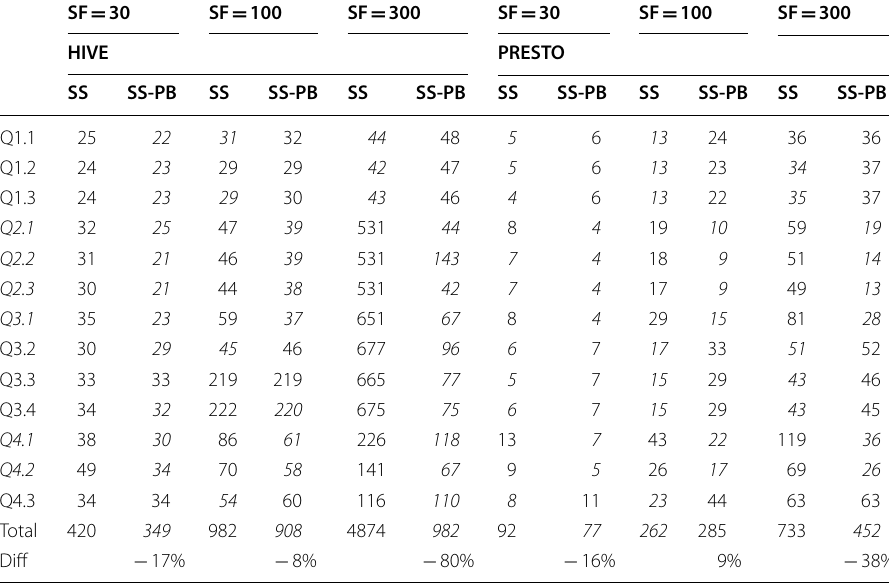
Table 10 SSB execution times (in seconds): partitioning by “S_Region” and bucketing by “Suppkey”. Retrieved from [10]